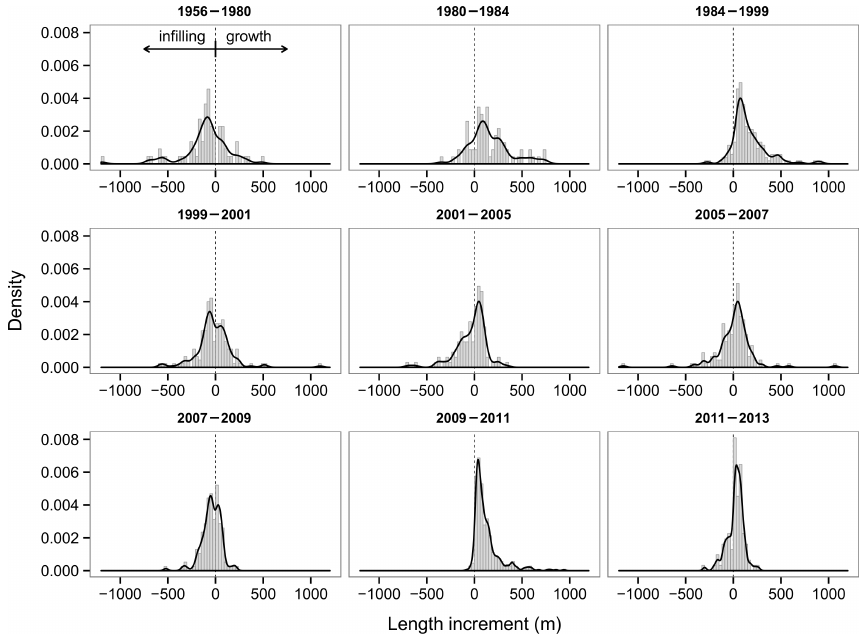
Figure 10. Gully headcut growth or decrease in the different periods between 1956 and